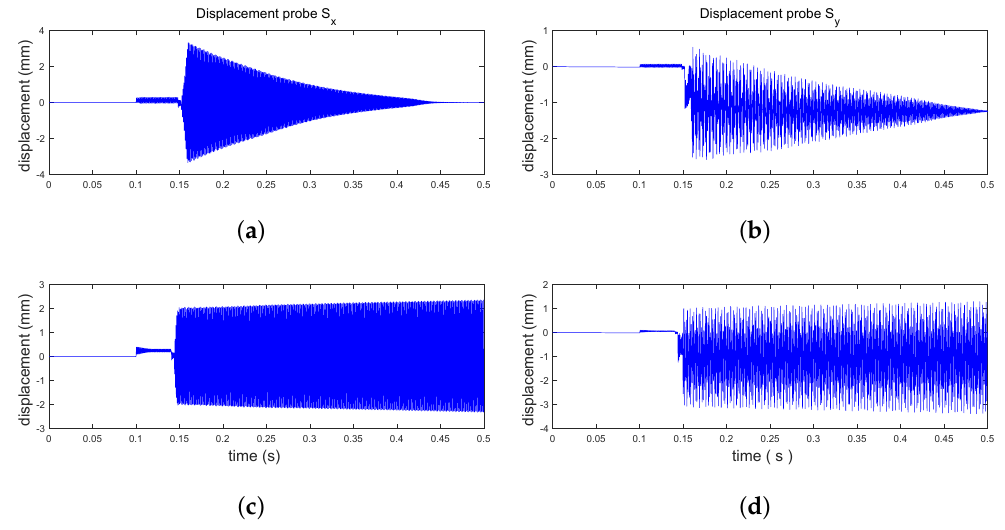
Figure 9. Displacement time history of node A. ( a ) Stable case; ( b ) stable case; ( c ) unstable case; ( d ) unstable